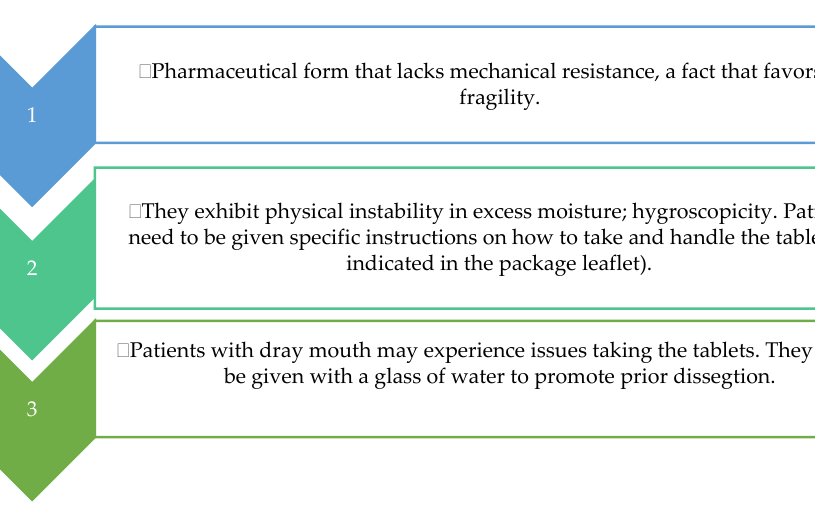
Figure 2. Disadvantages of ODT tablets.